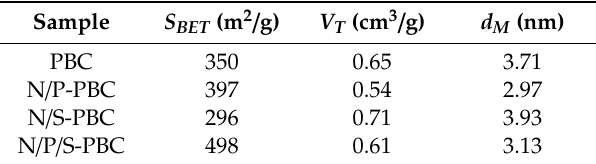
Figure 7. N 2 adsorption–desorption isotherms ( a ) and pore size distribution ( b ) curves of PBCs. Table 4. Pore parameters of the sample PBCs. (Calculated total surface S BET , total pore volume V T , average pore diameter d M ).